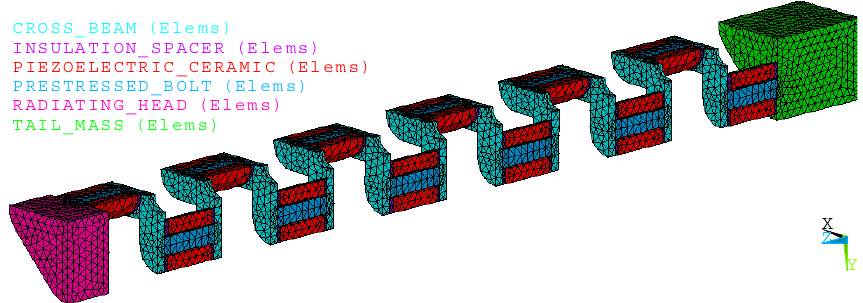
Figure 3. Finite element model of cascade-connected transducers with twelve segments.